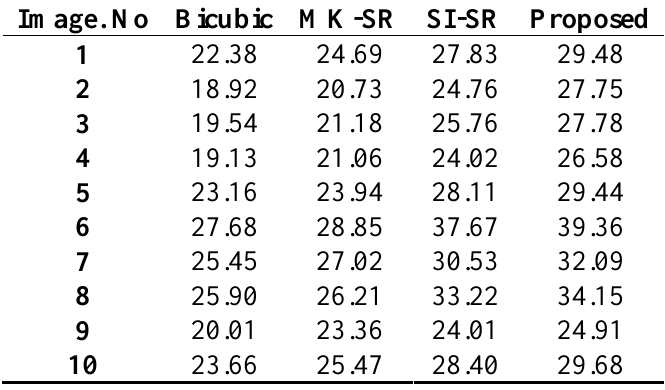
Table 2. PSNR computed for compressed images mentioned in Table 1. Image.